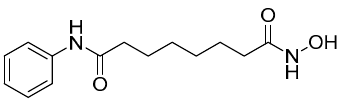
Figure 1. Structure of the HDACi suberoylanilide hydroxamic acid (SAHA).